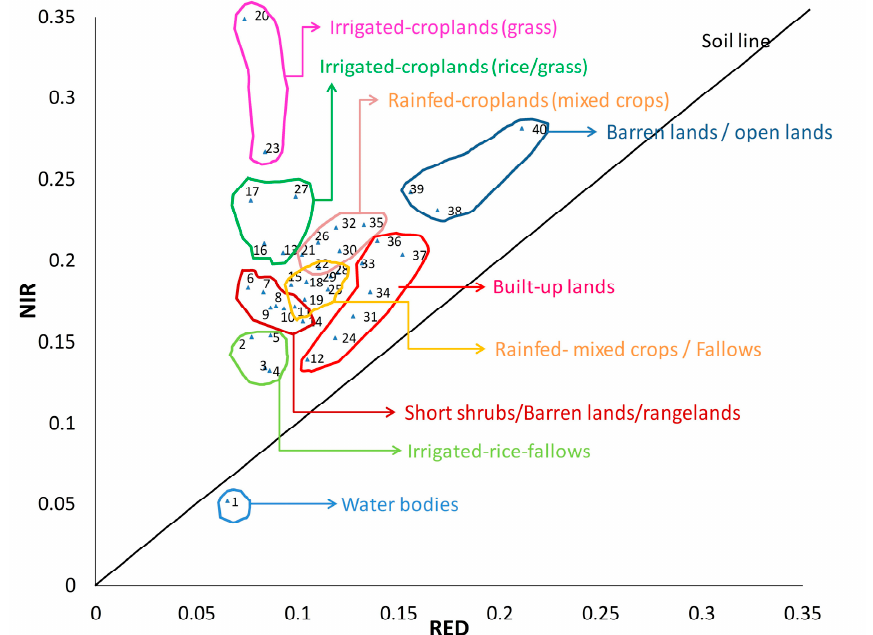
Figure 4. Single-date bi-spectral plot of unsupervised classes plotted by mean class reflectance in the red and NIR bands. red and NIR